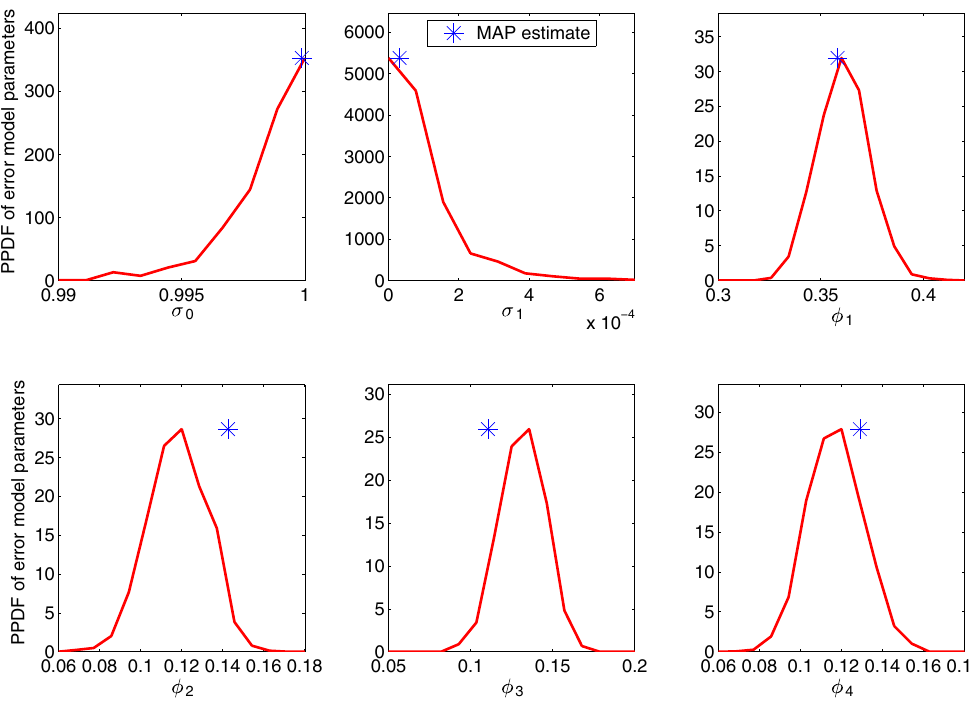
Figure 11. Estimated posterior probability density functions (PPDFs) of the six error model parameters.